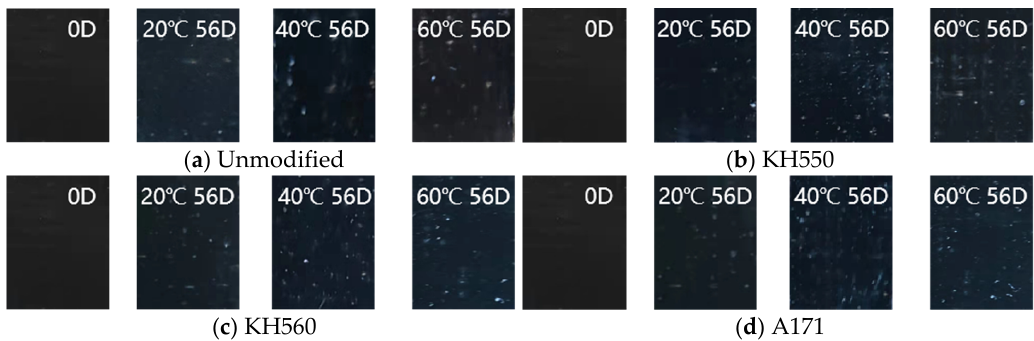
Figure 8. Appearance changes in a seawater environment.